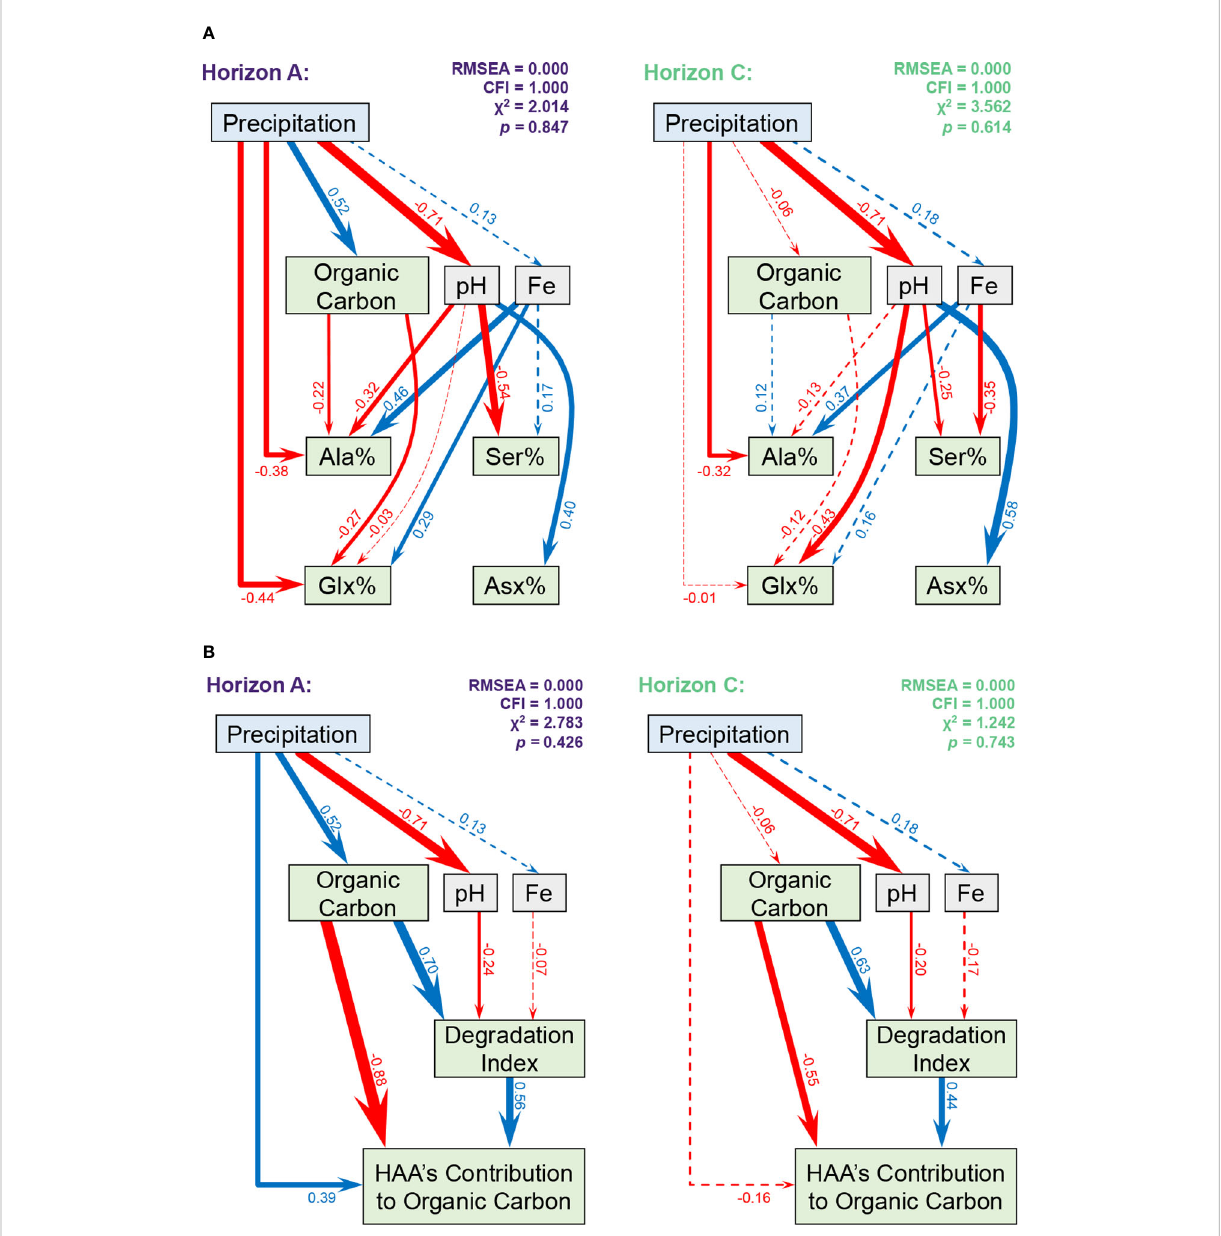
FIGURE 5 Modeldescribingprecipitation, butnottemperature, as aproximateanddistal mechanismcontrollingsoil HAAcompositionPathdiagramscomparingthe directandindirecteffectsof precipitationon (A) HAAcompositionand (B) HAA ’ scontributiontoorganiccarbonpool in horizonA(n=84)and horizonC (n=81). Red andbluepathsrepresentthe negative andpositiverelationships,respectively.Solidanddashed pathsindicatesigni fi cant andinsigni fi cant relationships,respectively. Thepaths ’ thicknessisscaledbasedonthe standardizedpathcoef fi cients